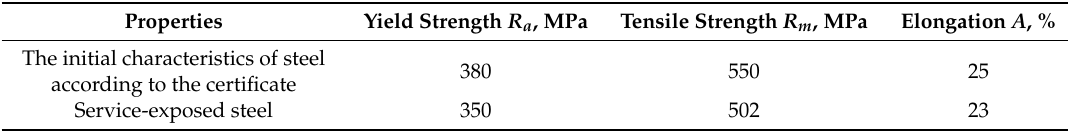
Table 7. The mechanical properties of the pipe’s